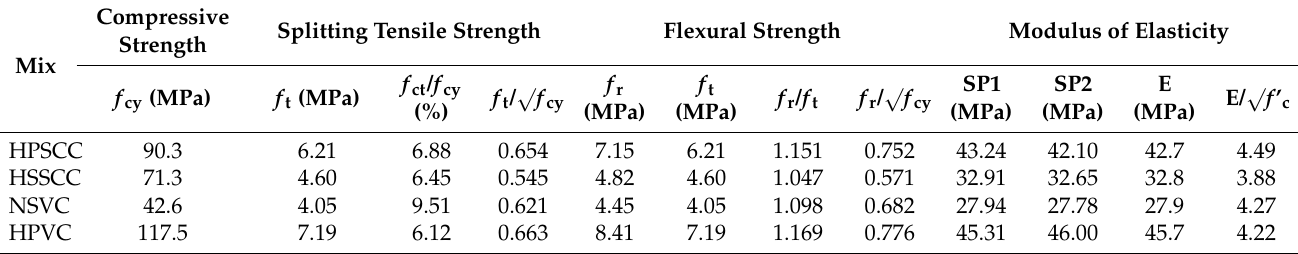
Table 7. Splitting tensile strength of Ø100 mm specimens, Flexural strength of 75 mm × 75 mm × 350 mm concrete prisms, and Modulus of Elasticity of Ø150 mm